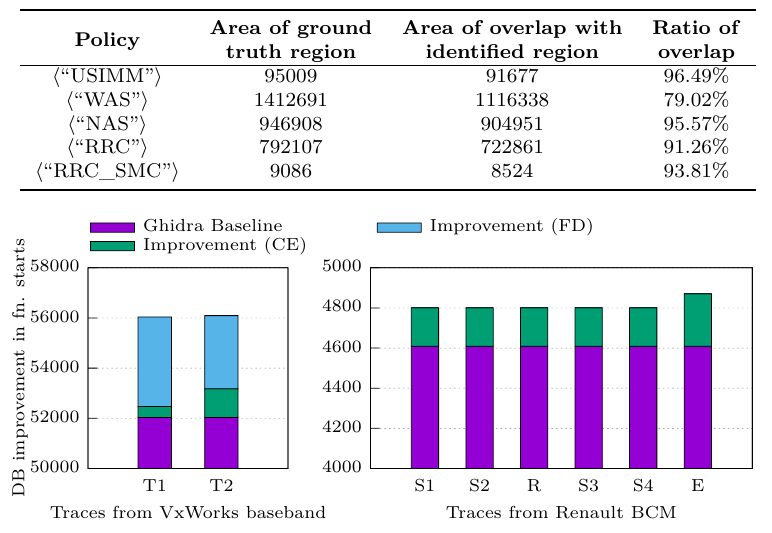
Figure 6: Left: Database improvement for VxWorks baseband firmware; Right: